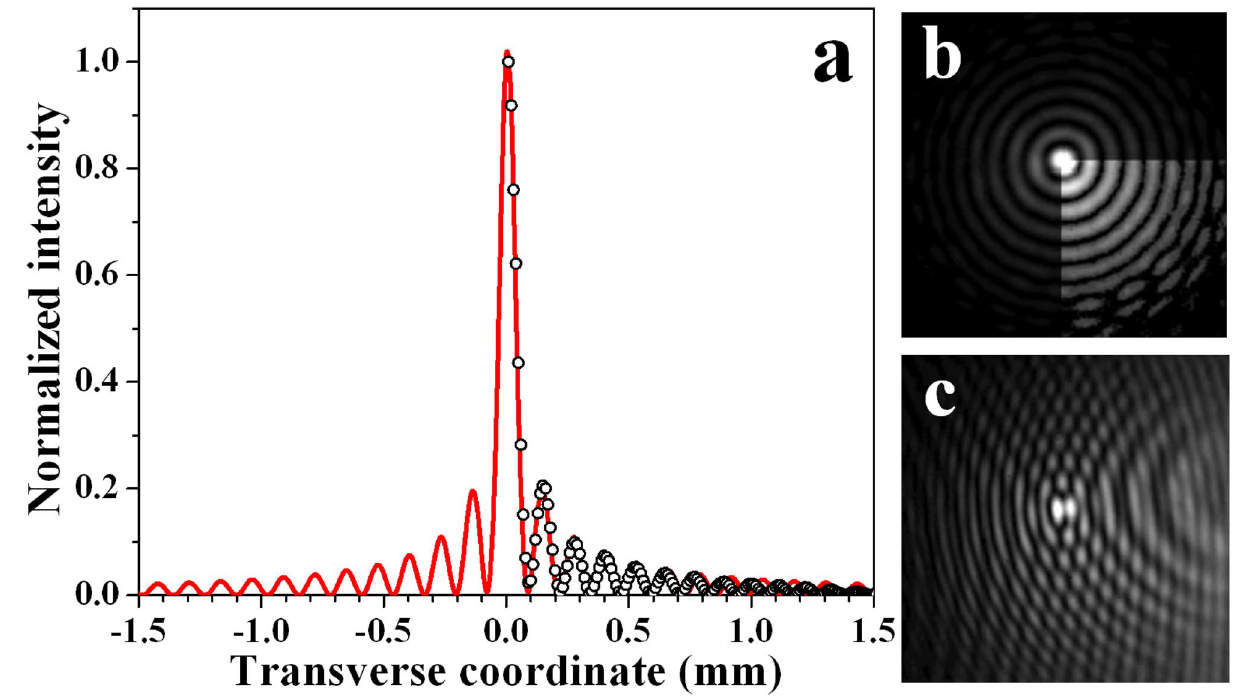
Figure 3. (a) Radial intensity profile of the zeroth-order GBB (hollow circles) generated by annihilating OV with a | TC | = 21 ( r 0 /ω 0 = 15.0 in the plane of the lens) and the respective numerically generated transverse beam cross-section (red solid curve). Power density distribution of this GBB (b) and interference pattern (c) obtained by overlapping it with an offset spherical wave. The CCD camera is located 15 cm (4 Rayleigh diffraction lengths z R of the focused pure Gaussian beam) behind the focus of the